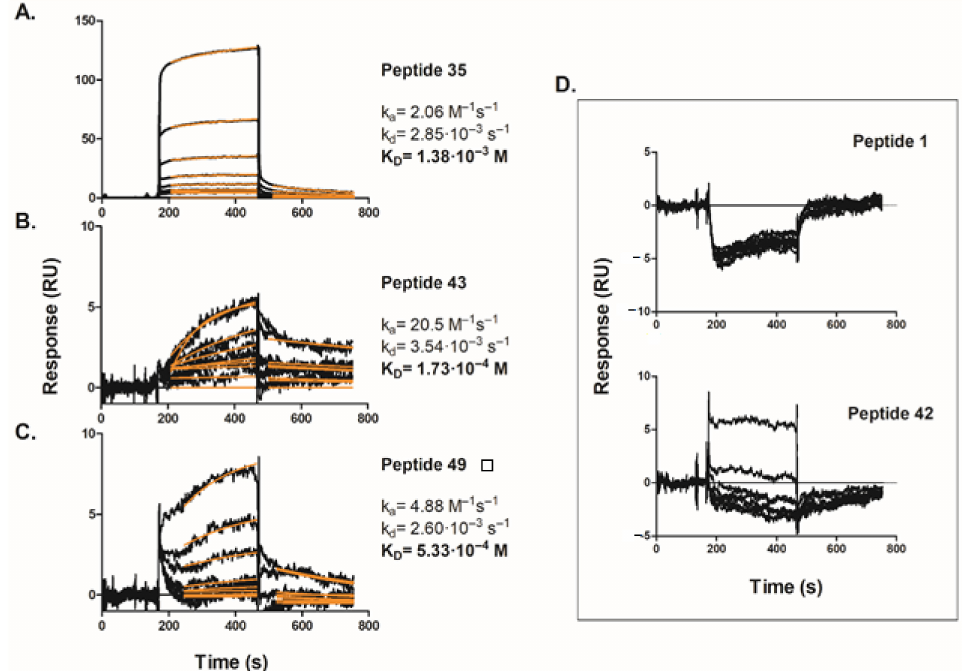
Figure 6. SPR sensorgrams of the selected TWEAK-Fn14 inhibitory peptides binding to immobilized human His6-TWEAK protein: ( A ) peptide 35, ( B ) peptide 43, ( C ) peptide 49 and ( D ) negative control peptides 1 and 42. The experimental data (black lines) were globally fit to a 1:1 binding model (red lines) using BIAevaluation, as described in Materials and Methods, to determine the indicated kinetic rate and affinity constants. Data are representative of at least three independent